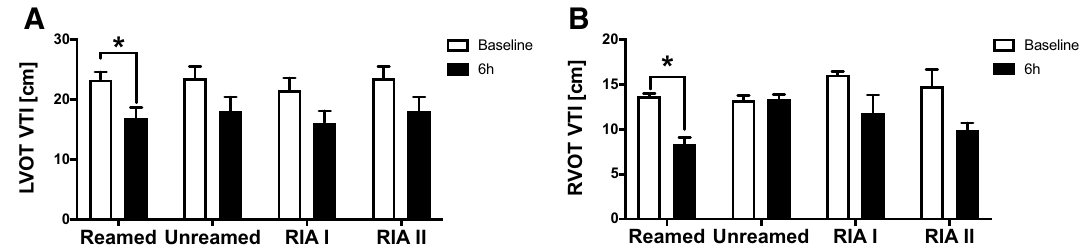
Figure 4. Outflow tract: ( A ) Left ventricular outflow tract velocity time integral (LVOT VTI) in l/min measured by Echocardiography at Baseline (white) and 6 h after femur fracture (black) in pigs and either nailing